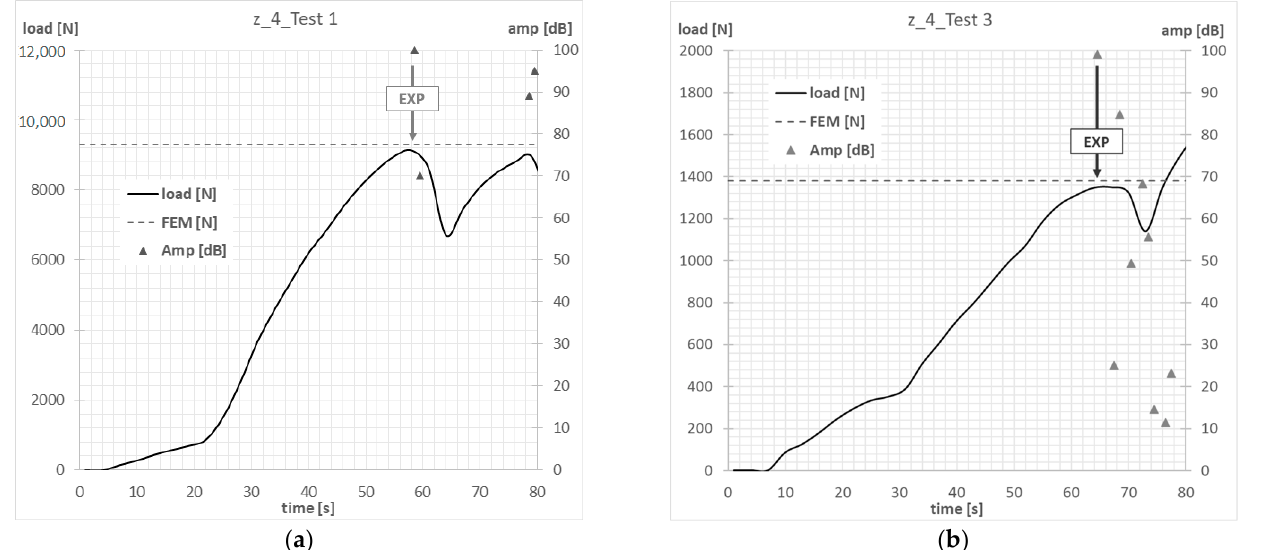
Materials 2022 , 15 , 7631 Figure 10. Column z_4—failure initiation force: ( a ) axial compression—Test 1; ( b ) eccentricity—Test 3.